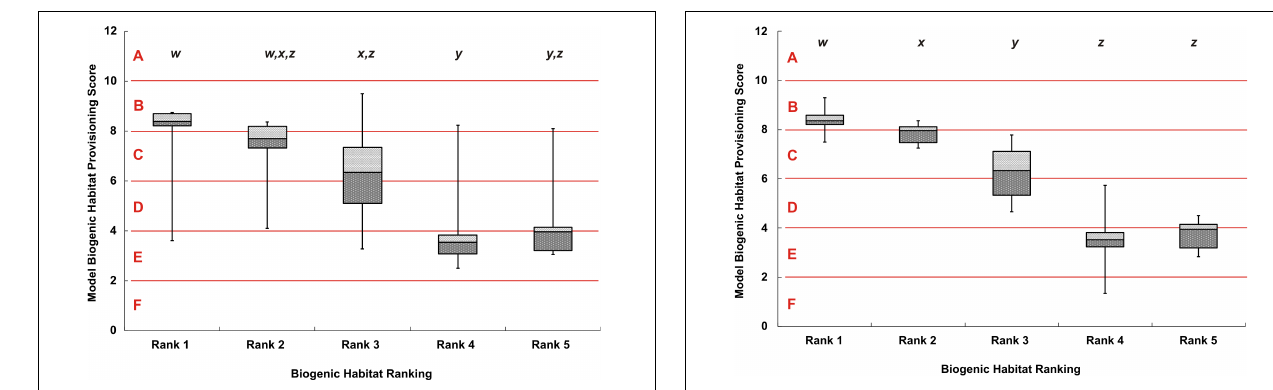
FIGURE 4 | Box whisker plot of modeled biogenic habitat provisioning scores, separated by the 5 ranks from video observations. The y -axis shows the numeric model scores with the alphabetized classes A–F. Error bars show the maximum and minimum biogenic habitat provisioning score for each video rank, dark-gray and light-gray boxes show the 25% and 75% quartiles respectively, away from the median line. Lowercase lettering at the top of the figure, w–z, indicates significant differences between rank classes based on the Dwass, Steel, and Critchlow—Fligner Method. TABLE 1 | Dwass, Steel, Critchlow-Fligner multiple comparison for model scores between biogenic habitat ranks (two-sided comparison) for raw data. Pairwise two-sided multiple comparison analysis